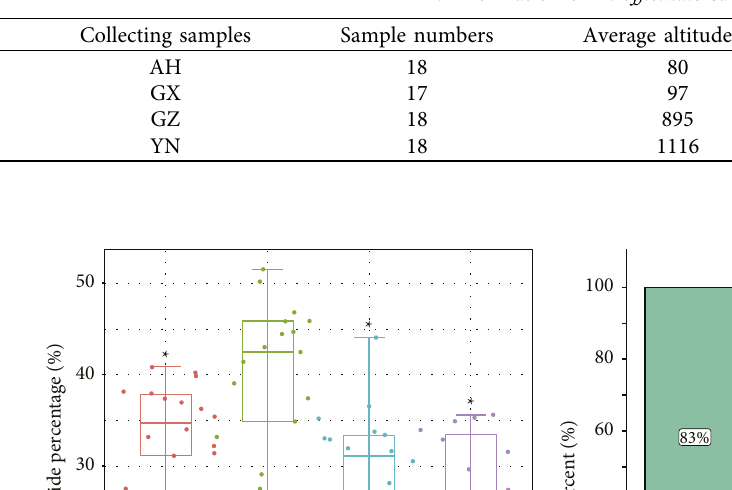
Table 1: Information of D. ofcinale